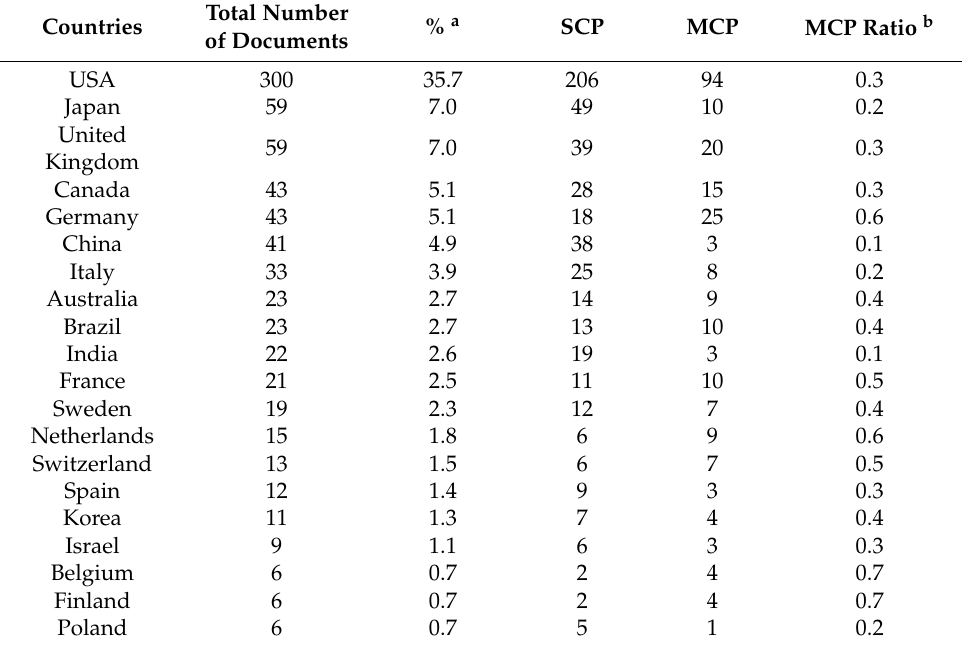
Figure 3. Geographical distribution map of the publications on telomere length in children. Table 2. Top 20 most prolific countries in publishing papers on telomere length in